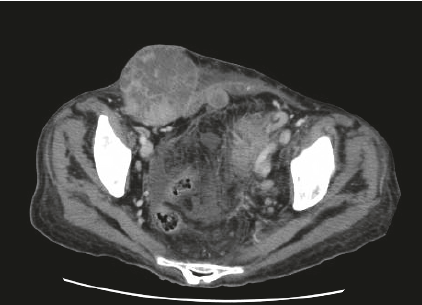
Figure 3: Histopathological examination showing clear-cell carci- noma of left ovary (H&E stain).